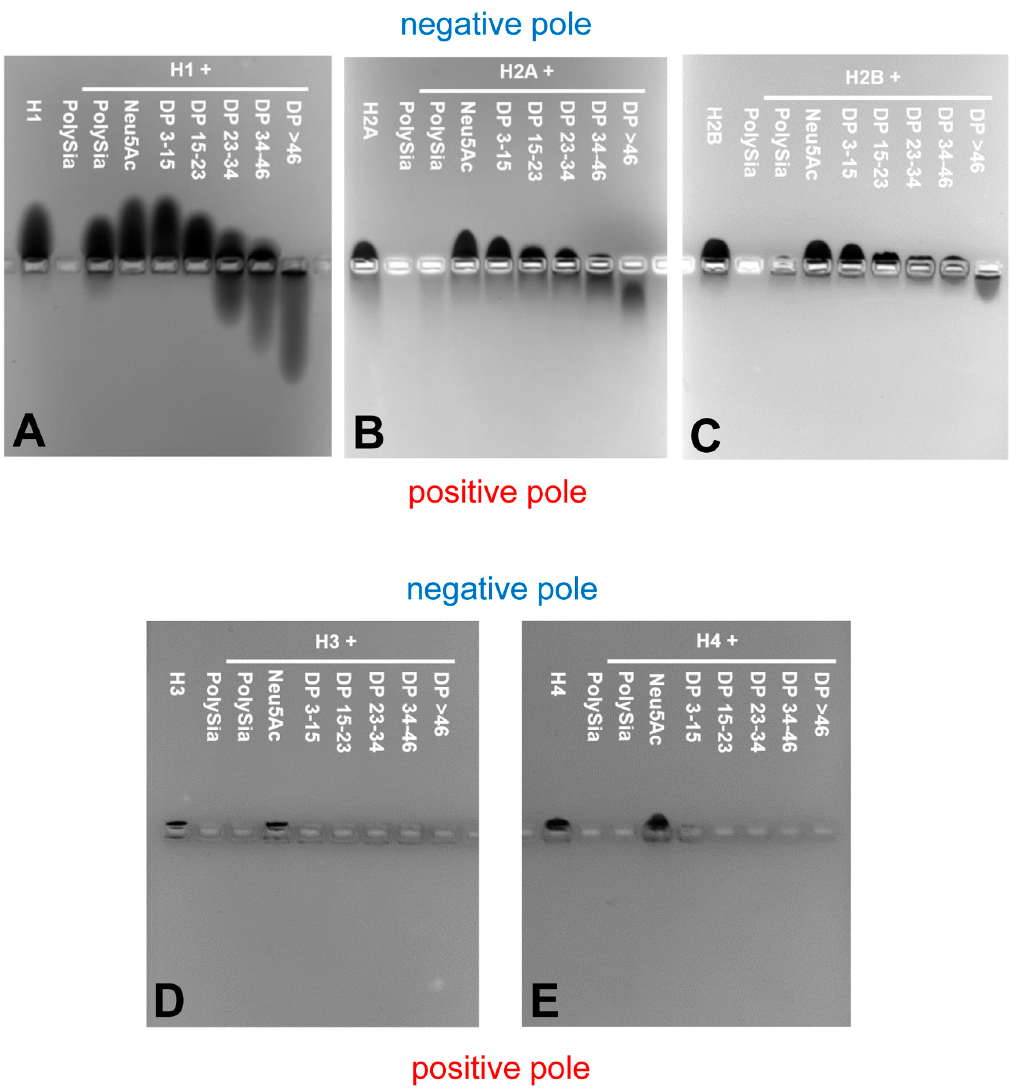
Figure 5. Non-covalent binding assays. PolySia interacts with individual histones in a degree of polymerization (DP)-dependent manner and causes a migration-shift in native gel electrophoresis. Proteins (5 μ g) and a mixture or defined DP of polySia (2.5 μ g) were incubated, electrophoretically separated and stained with Coomasie Blue. ( A ) Histone H1; ( B ) Histone H2A; ( C ) Histone H2B; ( D ) Histone H3; ( E ) Histone H4. Representative gels of three independent experiments.